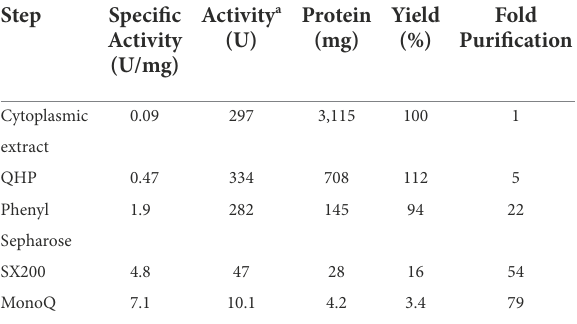
TABLE 1 Purification of BmWOR.